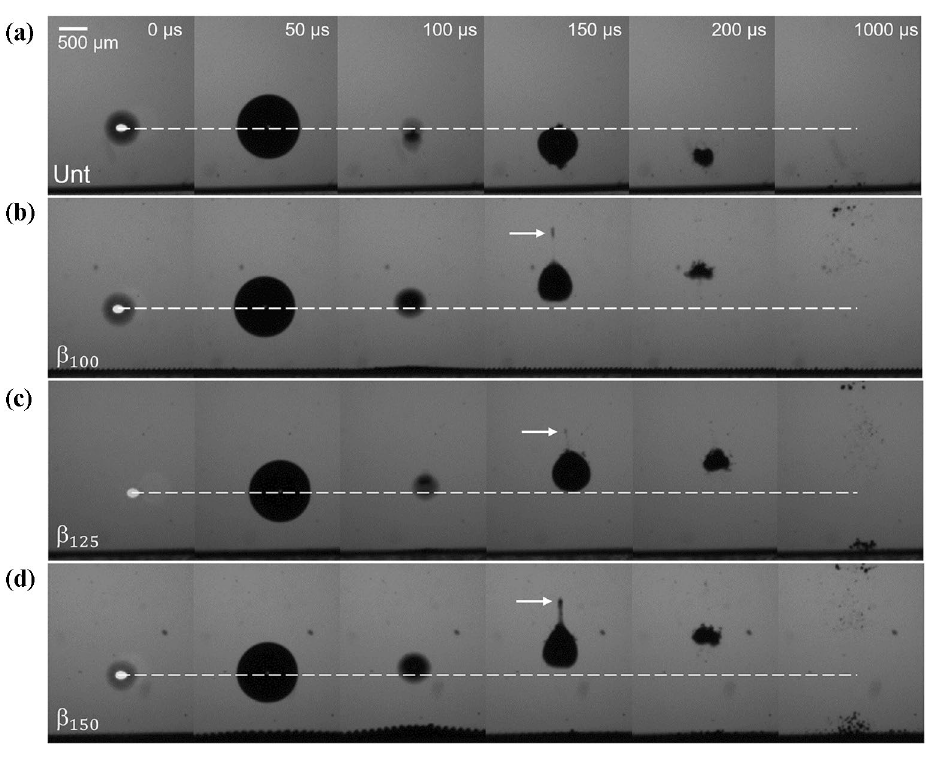
Figure 5. Comparison of a single cavitation bubble collapsing at a stand-off distance of γ = 2 from ( a ) untreated PDMS, ( b ) β 100 , ( c ) β 125 , and ( d ) β 150 microstructures. The black line at the bottom of each image is the surface.